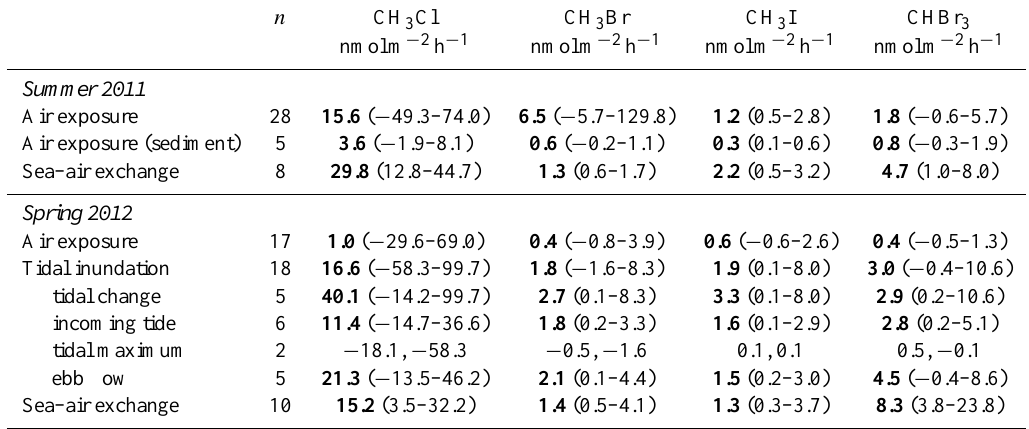
Table 3. Mean net fluxes (bold) and ranges of halocarbons from flux chamber experiments seagrass meadows and sediments, as well as those from sea–air exchange calculations. Data were obtained during the summer 2011 and spring 2012 campaigns in the Ria